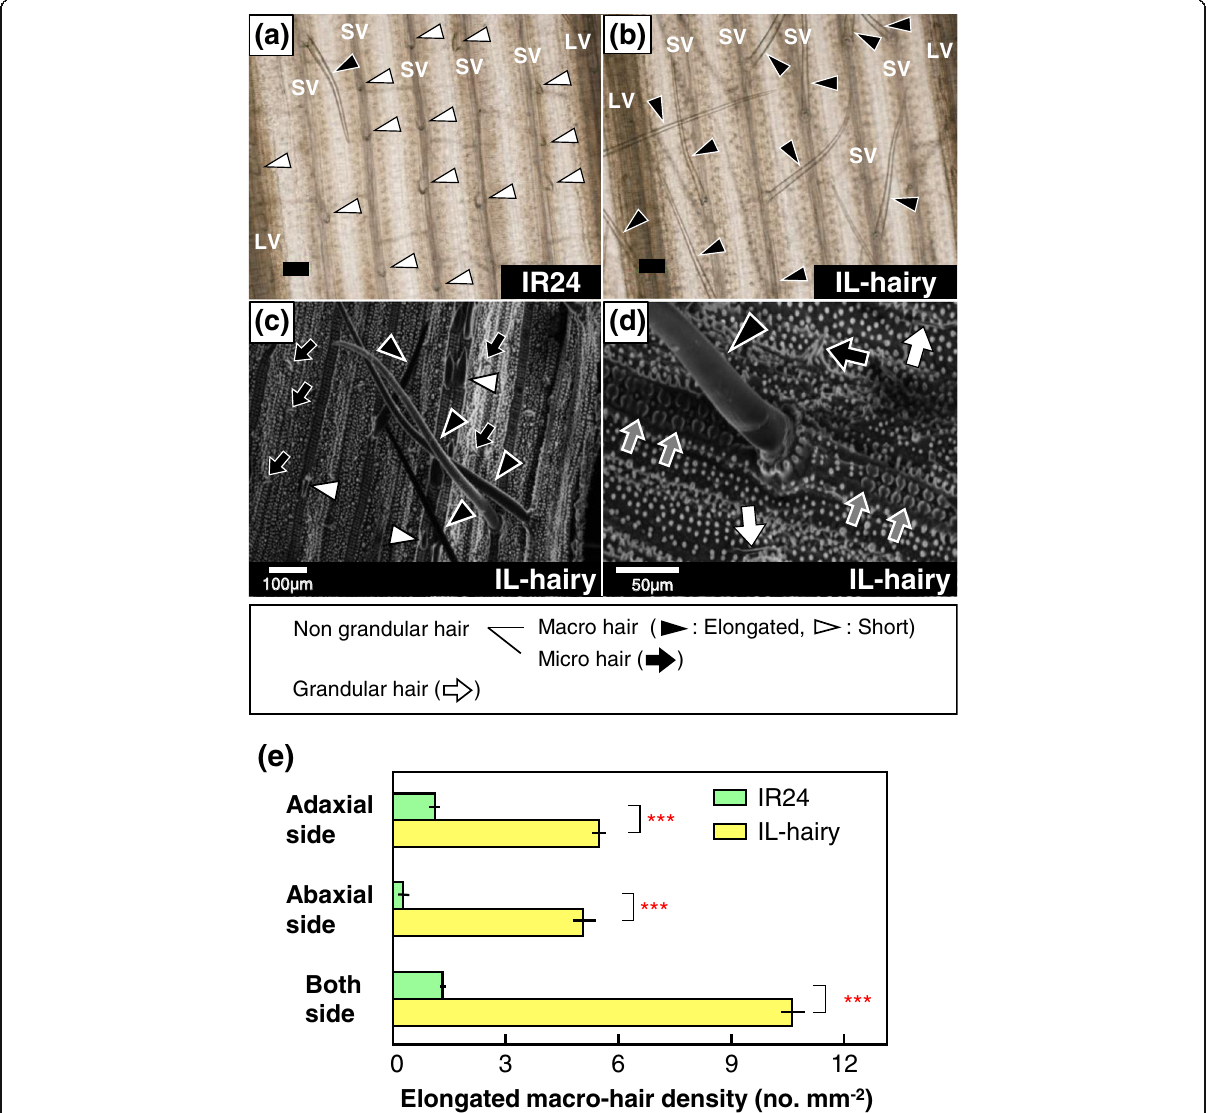
Fig. 2 Light microscopic and scanning electronic microscopic images of leaf surface, and leaf hair density. a, b Light microscopic images of IR24 ( a ) and IL-hairy ( b ). Scale bars , 100 μ m. c, d Scanning electronic microscopic images of adaxial surface of IL-hairy at tillering stage. Black arrowheads , elongated macro-hairs; white arrowheads , short macro-hairs; black arrows , micro-hairs; white arrows , glandular hairs; gray arrows, silica cells. LV, large vascular bundle; SV, small vascular bundle. e Density of elongated macro-hairs on adaxial side, abaxial side, and both sides in leaves of IR24 and IL-hairy at booting stage. Data are means±SD ( n =3 or 4). *** P =0.001 by Student ’ s t -test